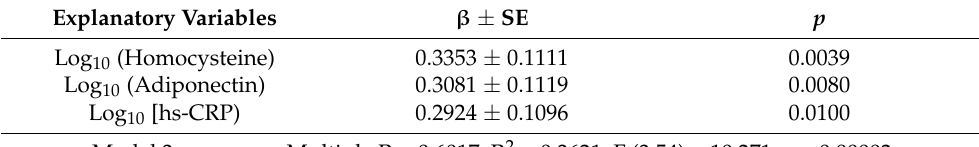
Table 5. Multiple linear regression analysis for correlates of 11-dehydro-thromboxane